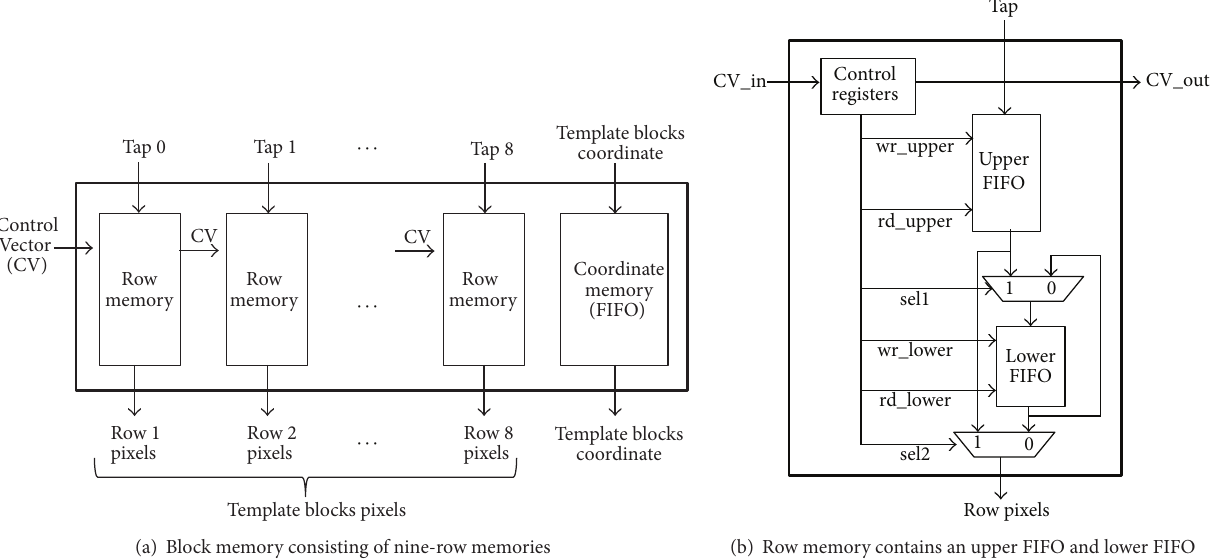
Figure 6: Block memory architecture for storing template blocks.